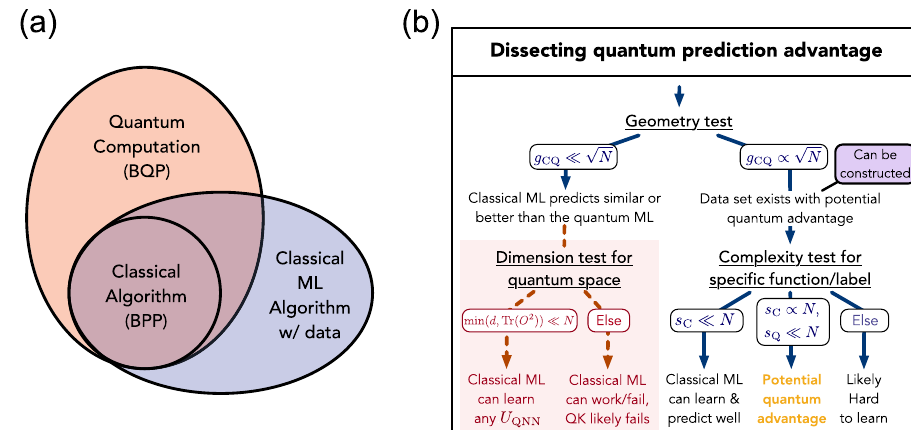
Fig. 1 Illustration of the relation between complexity classes and a fl owchart for understanding and prescreening potential quantum advantage. a We cartoon the separation between problem complexities that are created by the addition of data to a problem. Classical algorithms that can learn from data de fi ne a complexity class that can solve problems beyond classical computation (BPP), but it is still expected that quantum computation can ef fi ciently solve problems that classical ML algorithms with data cannot. A rigorous de fi nition and proof for the separation between classical algorithms that can learn from data and BPP/BQP is given in Supplementary Section 2. b The fl owchart we develop for understanding the potential for quantum prediction advantage. N samples of data from a potentially in fi nite depth QNN made with encoding and function circuits U enc and U QNN are provided as input along with quantum and classical methods with associated kernels. Tests are given as functions of N to emphasize the role of data in the possibility of a prediction advantage. One can fi rst evaluate a geometric quantity g CQ that measures the possibility of an advantageous quantum/classical prediction separation without yet considering the actual function to learn. We show how one can ef fi ciently construct an adversarial function that saturates this limit if the test is passed, otherwise the classical approach is guaranteed to match performance for any function of the data. To subsequently consider the actual function provided, a label/function-speci fi c test may be run using the model complexities s C and s Q . If one speci fi cally uses the quantum kernel (QK) method, the red dashed arrows can evaluate if all possible choices of U QNN lead to an easy classical function for the chosen encoding of the